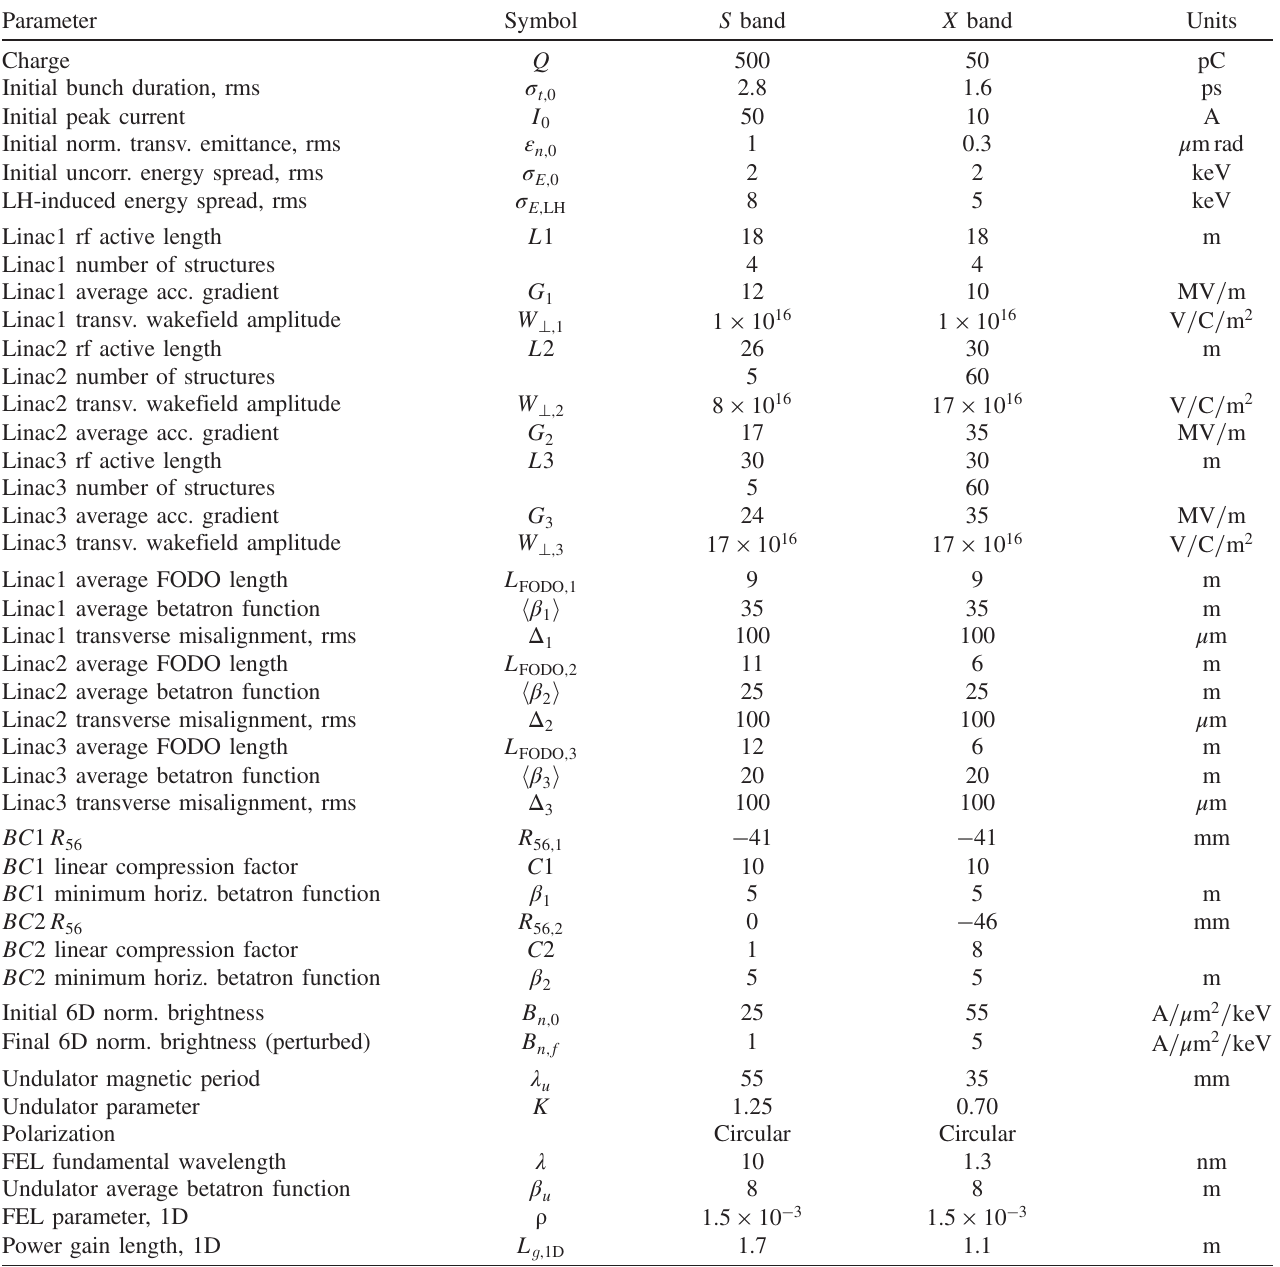
TABLE II. Reference electron beam, accelerator, and FEL parameters for the SL and the XL systems.